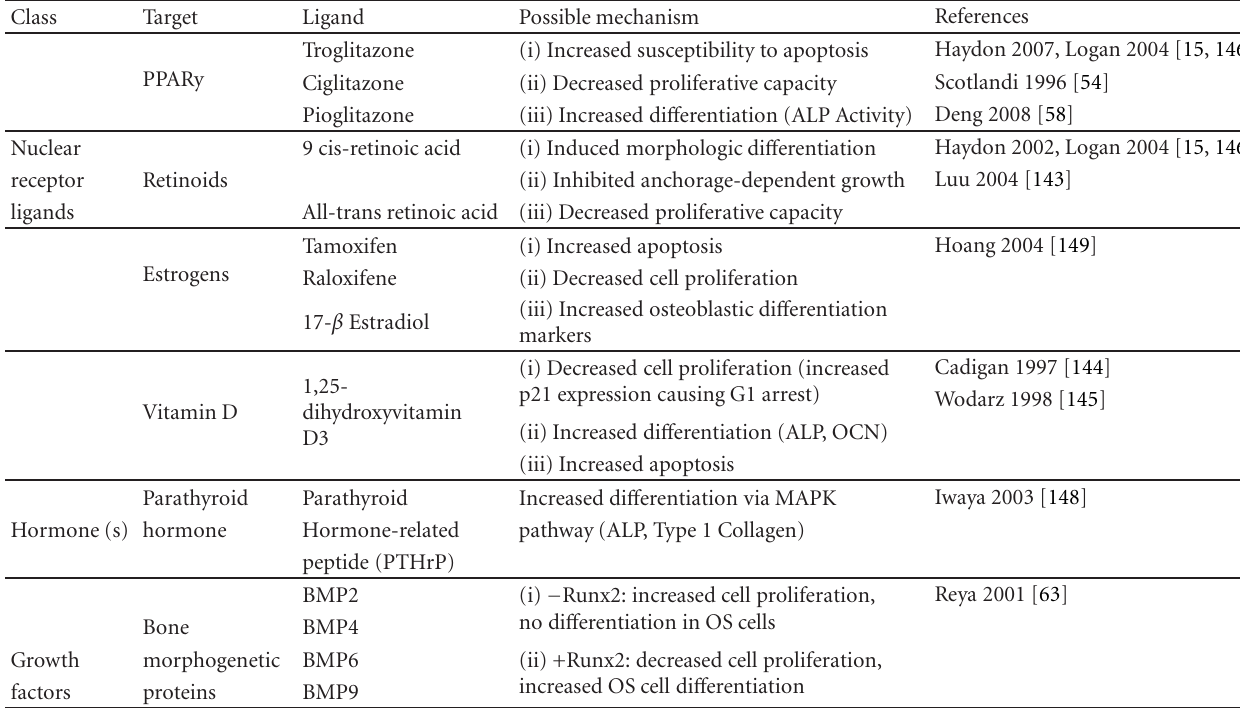
Table 1: Summary of some currently used di ff erentiation agents in human osteosarcoma cells. These di ff erentiation agents are in general nonspecific di ff erentiation-promoting agents, and are able to promote osteogenic di ff erentiation in mesenchymal stem cells. These agents can inhibit the proliferation and induce apoptosis in OS